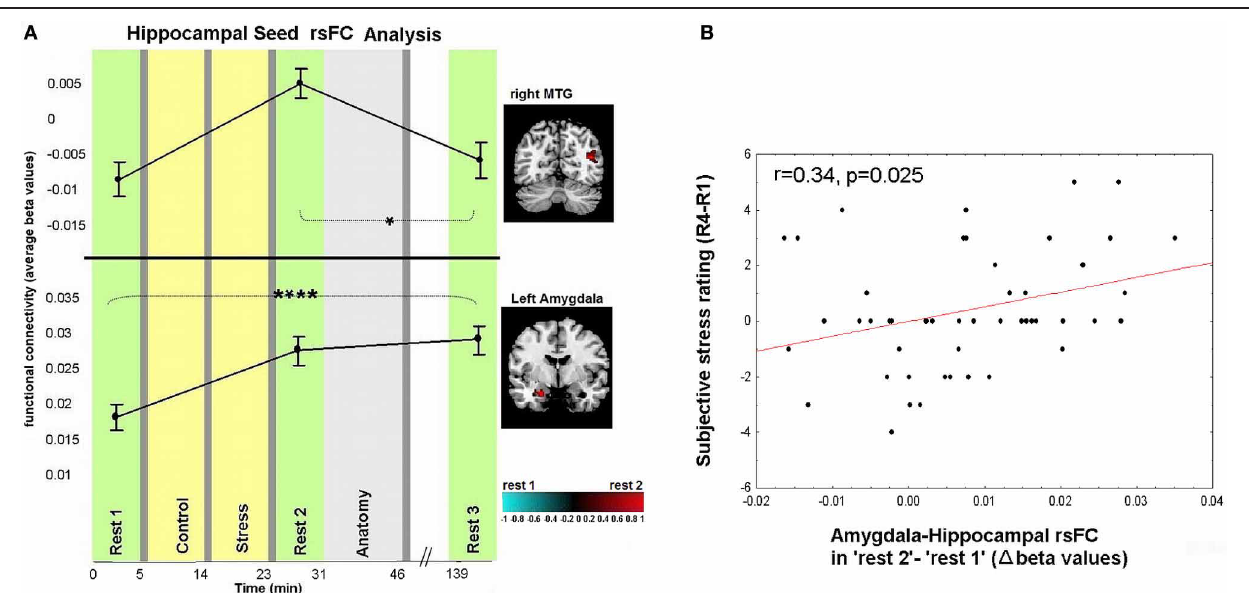
small volume corrected (with at least 20 voxels). T -score scale is shown at the bottom. Error bars indicate standard error. ∗ p < 0 . 05, ∗∗∗∗ p < 0 . 0001. See Table 2 for specific p -values. (B) Pearson correlation between subjective stress sensation (measured 20min post-stress subtracting the initial rating post-“rest 1,” R4-R1), and early stress-induced change in amygdala-hippocampal rsFC as measured during “rest 2” relative to “rest 1.”